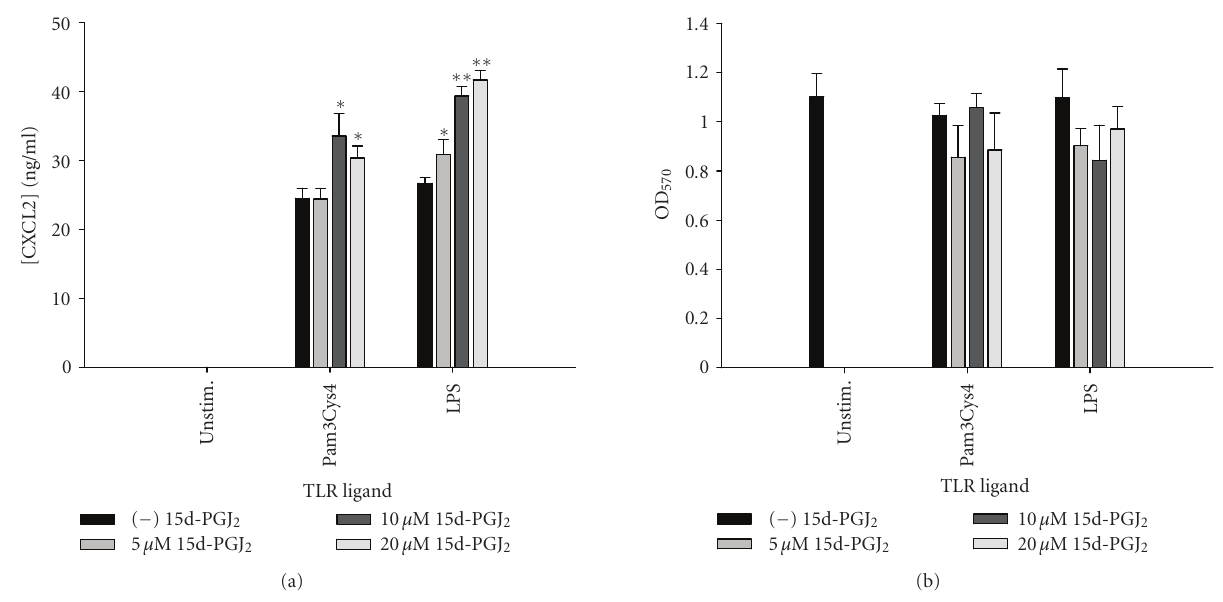
Figure 12: CXCL2 release is augmented in astrocytes by 15d-PGJ 2 in response to distinct TLR ligands. Primary astrocytes were plated at 1 × 10 5 cells/well in 96-well plates and incubated overnight. The following day, cells were pretreated for 1hour with the indicated concentrations of 15d-PGJ 2 prior to the addition of Pam3Cys4 or LPS. Cell-conditioned supernatants were collected at 24 hours following TLR ligand exposure, whereupon CXCL2 levels were determined by ELISA (a). The e ff ects of 15d-PGJ 2 on astrocyte viability were assessed using an MTT assay (b). Significant di ff erences between astrocytes treated with TLR ligands alone versus TLR ligands + 15d-PGJ 2 are noted with asterisks ( ∗ P < . 05; ∗∗ P < . 001). Results presented are representative of two independent